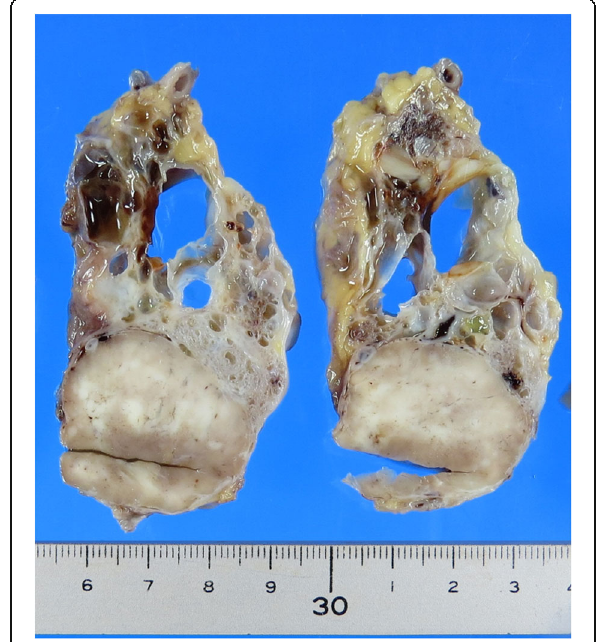
Fig. 5 Gross photograph of a pancreatic neuroendocrine tumor in the tail and the surrounding serous cyst neoplasms